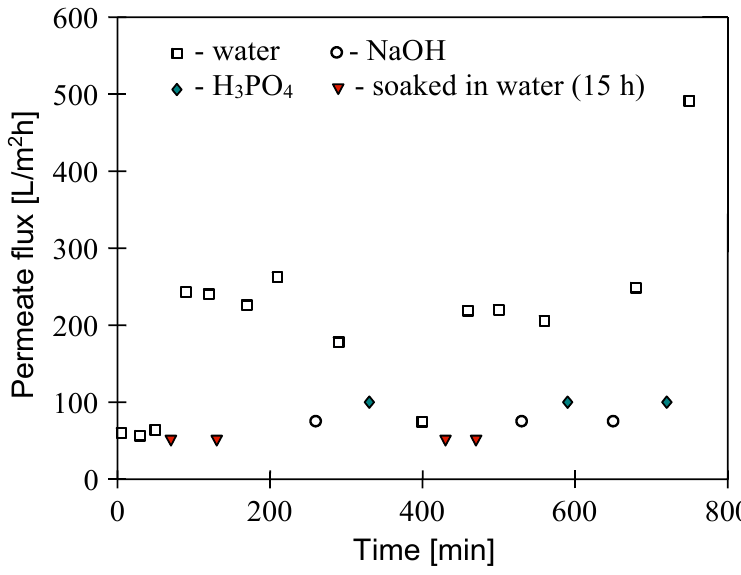
Figure 19. Variations in permeate flux during membrane cleaning after MF of oily wastewater #2.